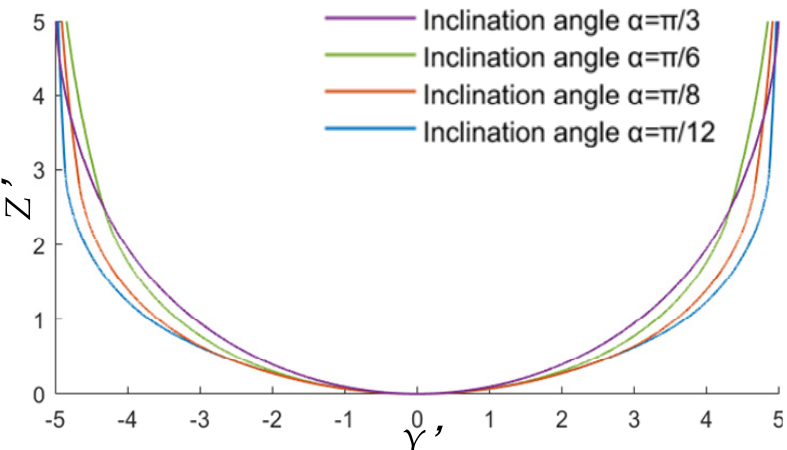
Figure 8. Intersection curves of DACT and normal section Y’-O’-Z’ .